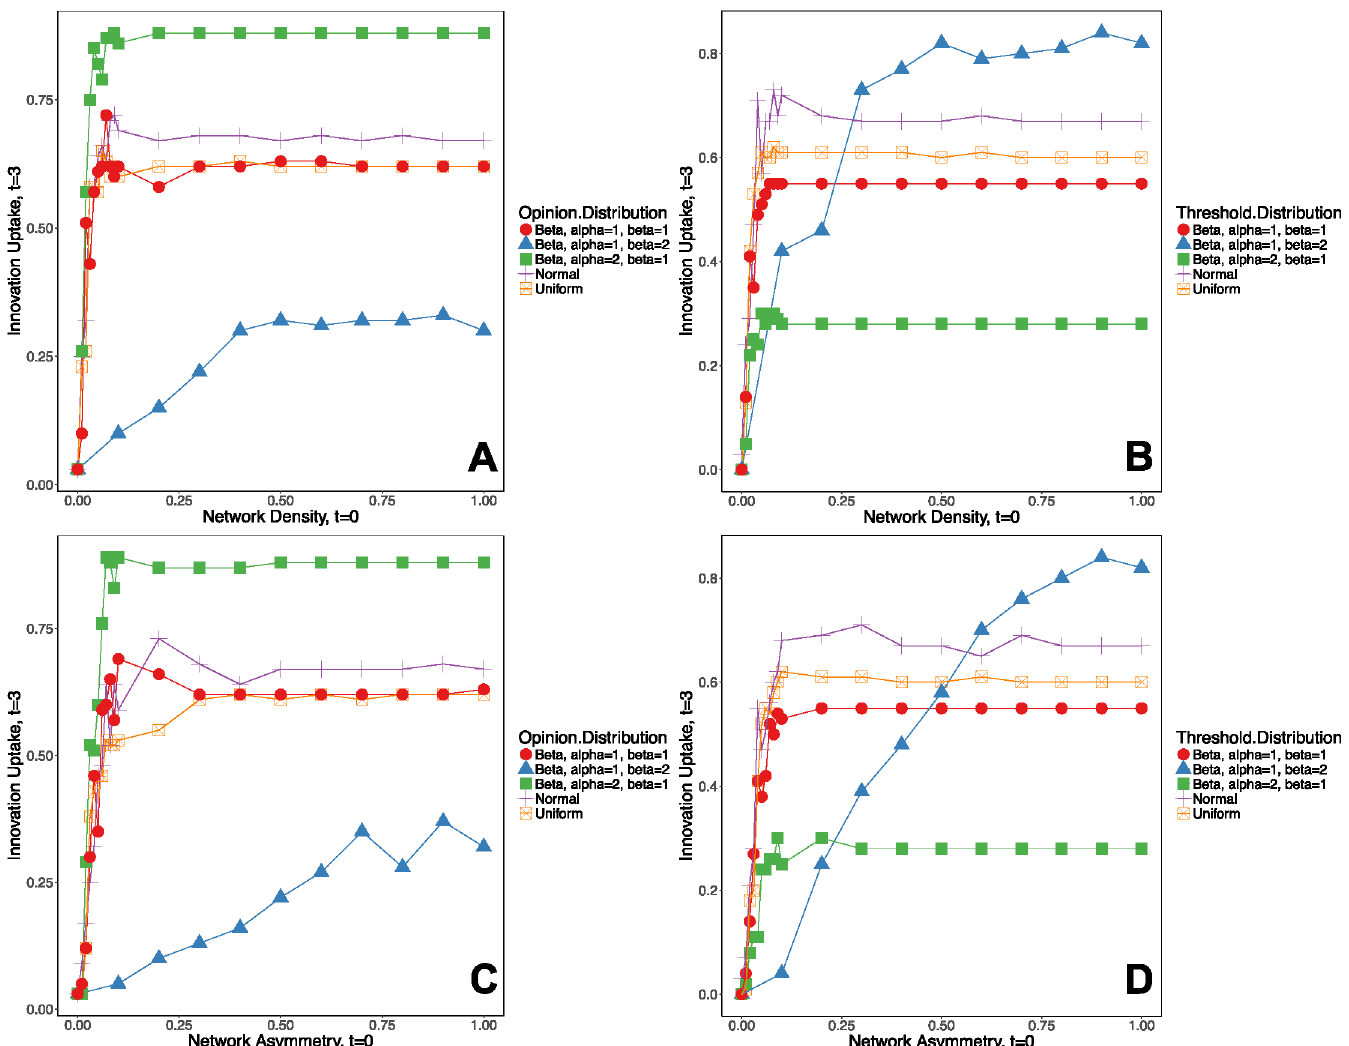
Fig 5. Simulated innovation diffusion on a Bernoulli random network varying the network density and network asymmetry. Y-axis shows the fraction of nodes (individuals) adopting the innovation. A shows diffusion on networks, varying network density and the distribution of initial opinions p (assuming normally distributed individual thresholds v ). B shows diffusion on networks, varying network density and the distribution of adoption thresholds v (assuming normally distributed individual opinions p ). C shows diffusion on networks, varying network asymmetry and the distribution of initial opinions p (assuming normally distributed individual thresholds v ). D shows diffusion on networks, varying network asymmetry and the distribution of adoption thresholds v (assuming normally distributed individual opinions p ).